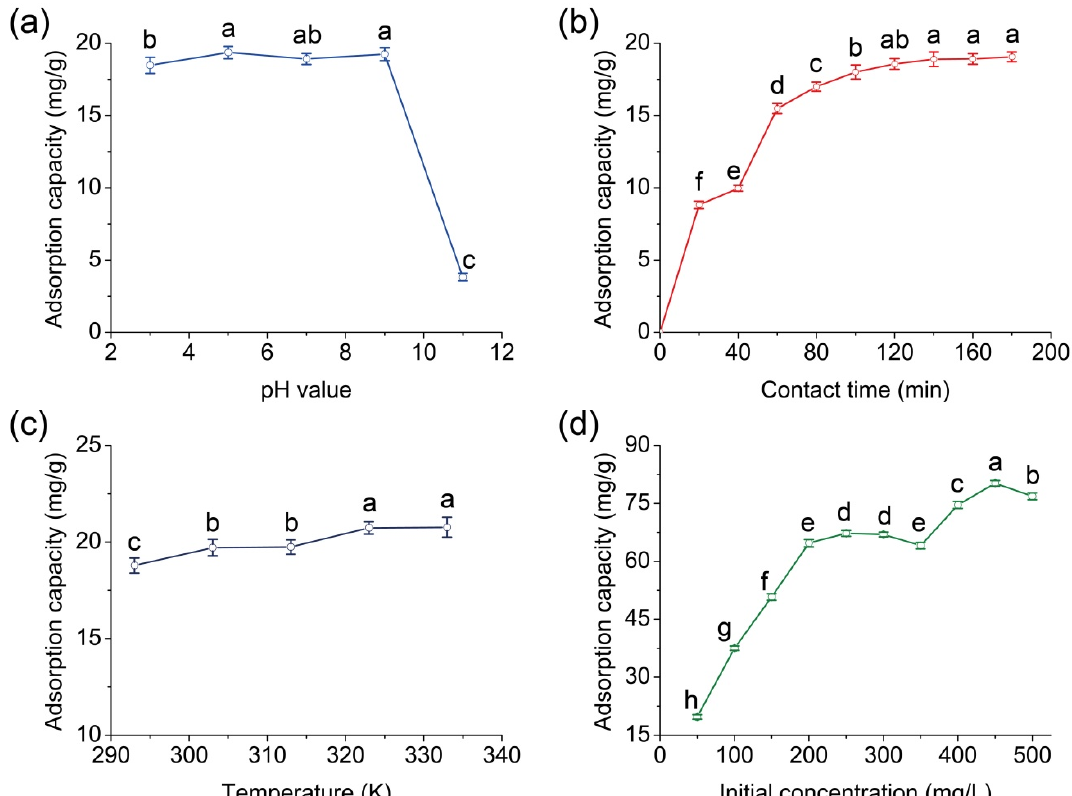
Figure 3. Effects of pH ( a ), contact time ( b ), temperature ( c ), and initial concentration ( d ) on MRCM adsorption of methyl orange at 303 K. (The reaction conditions in ( a – c ) are: the concentration of methyl orange is 50 mg/L, and the amount of MRCM is 0.1 g. The reaction conditions in ( d ) are: the reaction temperature is 30 °C, and the amount of MRCM is 0.1 g. Different letters in each of Figure ( a – d ) mean significant difference at 0.05 level ( p < 0.05, n = 3). Methyl orange usually exists as -SO 3 − 1 in the aqueous phase. However, at pH 11, numerous OH - would compete with methyl orange anion for MRCM adsorption